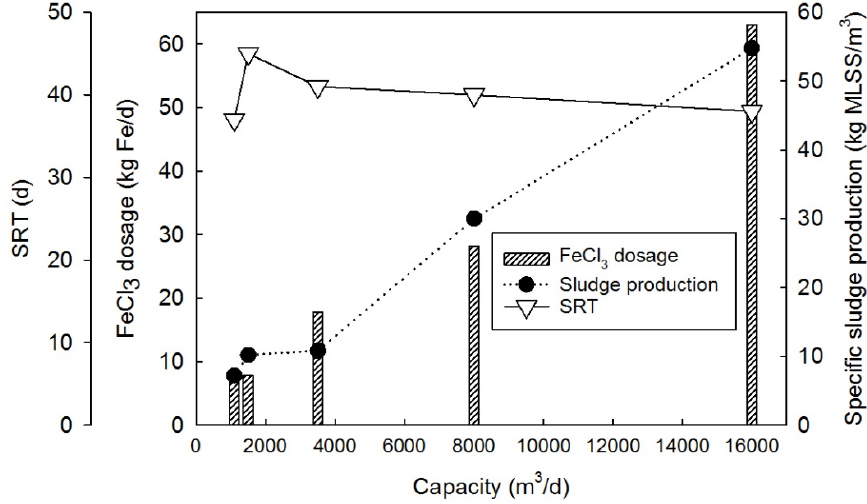
Figure 4. FeCl 3 dosage and sludge production from the full-scale DMBR TM